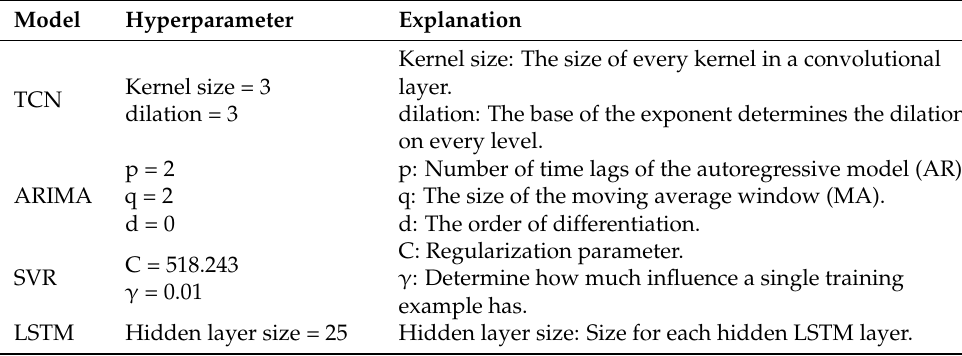
Table 1. The detailed settings of used